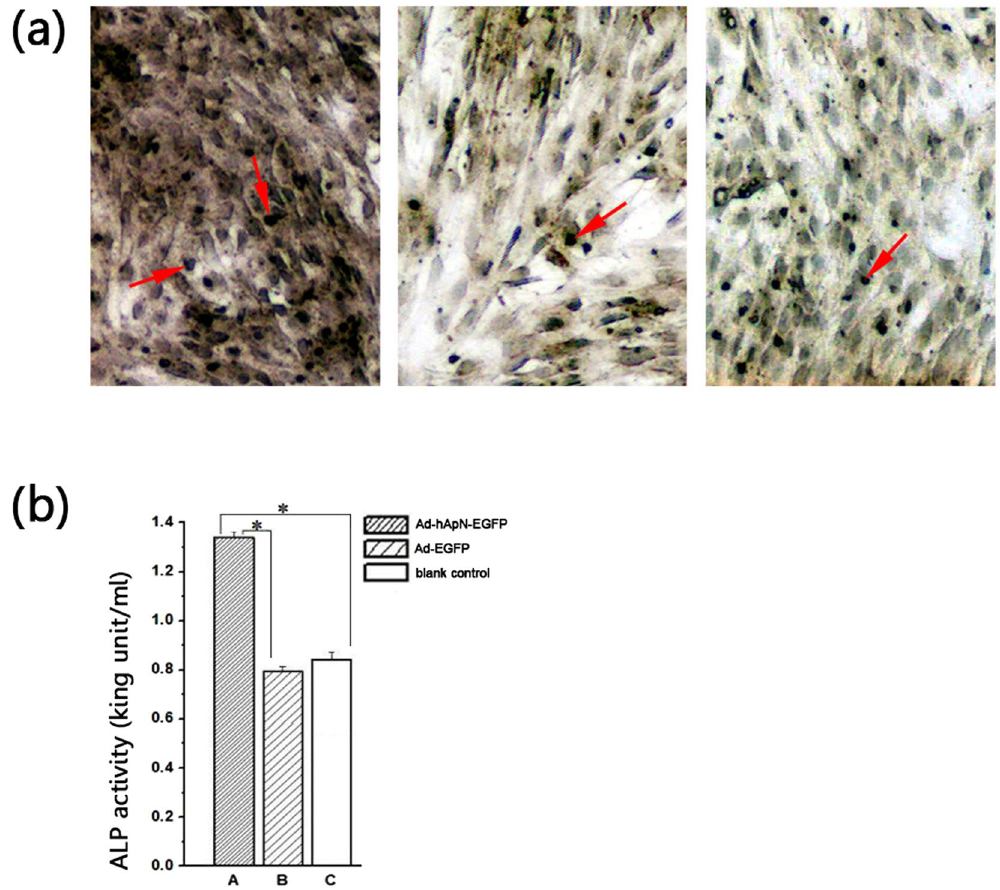
Figure 7. ALP staining/activity assays. ( a ) ALP staining was visualized under microscopy. More black cobalt sulfide precipitation (red arrow) were formed in Group A; ( b ) Significantly higher ALP activity was shown in group A compared with the other two groups (p < 0.05).